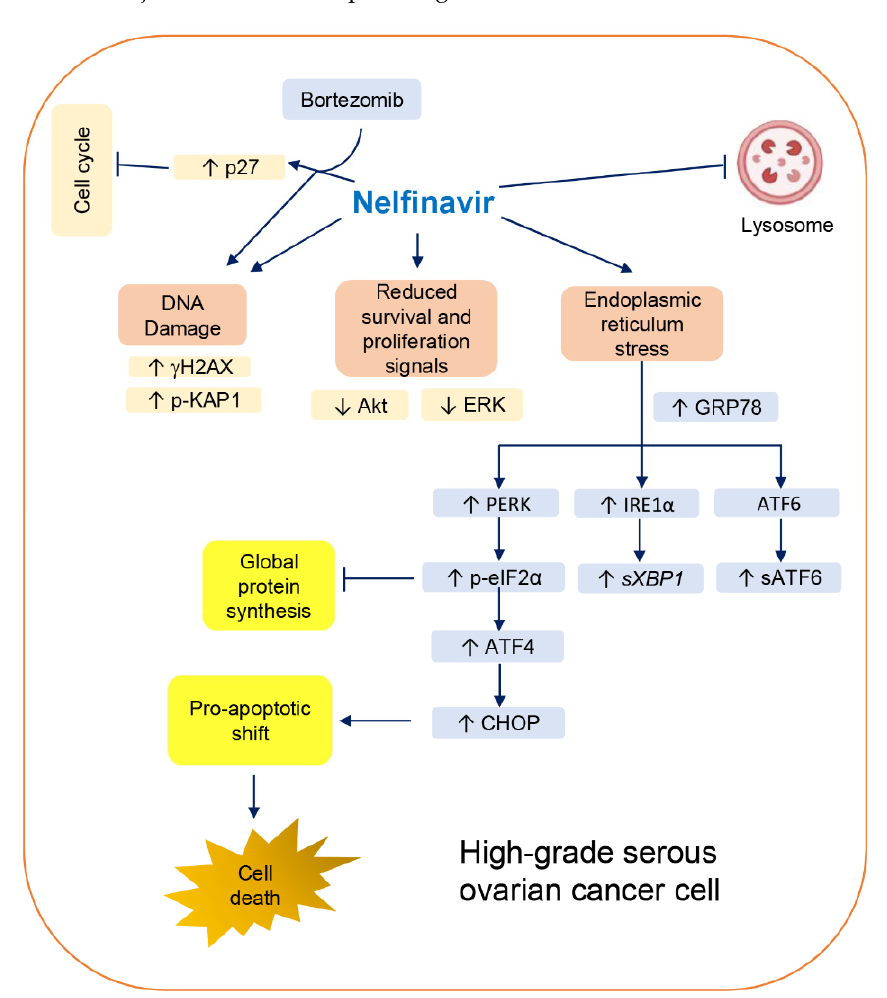
Figure 7. Schematic representation of the proposed mechanism of NFV-mediated cytotoxicity in HGSOC cells regardless of platinum sensitivity. NFV triggers DNA damage, reduces survival and proliferation signaled by AKT and ERK, and activates the three arms of the UPR: (1) IRE1 α -XBP1, (2) PERK-eIF2 α -ATF4-CHOP, and (3) ATF6 cleavage. Phospho-eIF2 α leads to inhibition of global protein synthesis, and, downstream of it, ATF4-CHOP-mediated proapoptotic shift triggers the cleavage of executioner caspase-7 to elicit cell death. Additionally, NFV impairs the autophagic clearance, likely via lysosome inhibition. Finally, NFV potentiates the cytotoxicity of proteasome inhibitor BZ by increasing the level of cell cycle inhibitor p27 kip1 , while reducing clonogenic survival (not shown), denoting a long-lasting toxicity that is likely the consequence of sustained DNA dam- age.